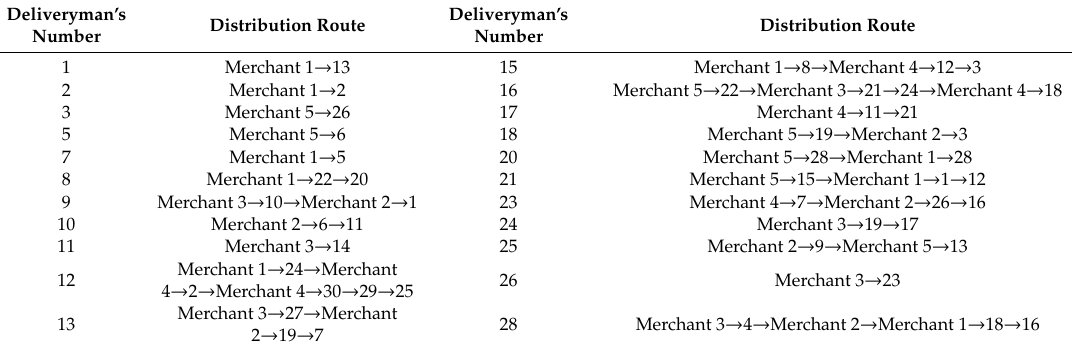
Table 3. Routes obtained by using the